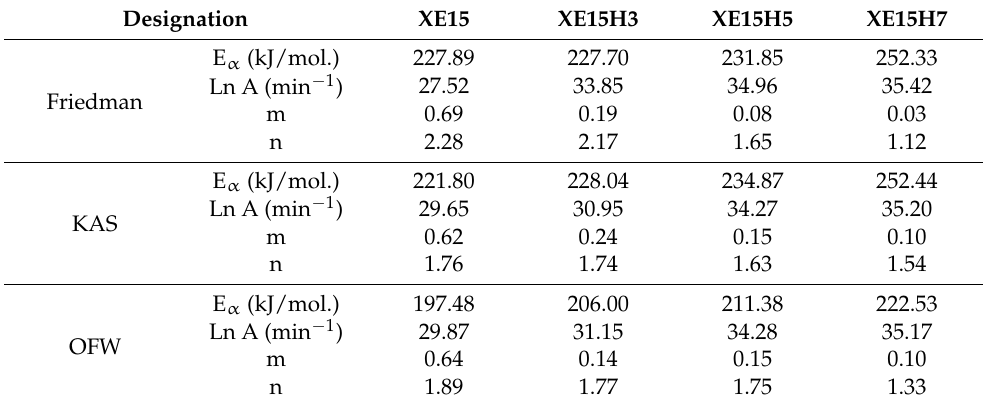
Table 7. Degradation parameters obtained through using autocatalytic approach for various XNBR/epoxy/XHNT nanocomposites.